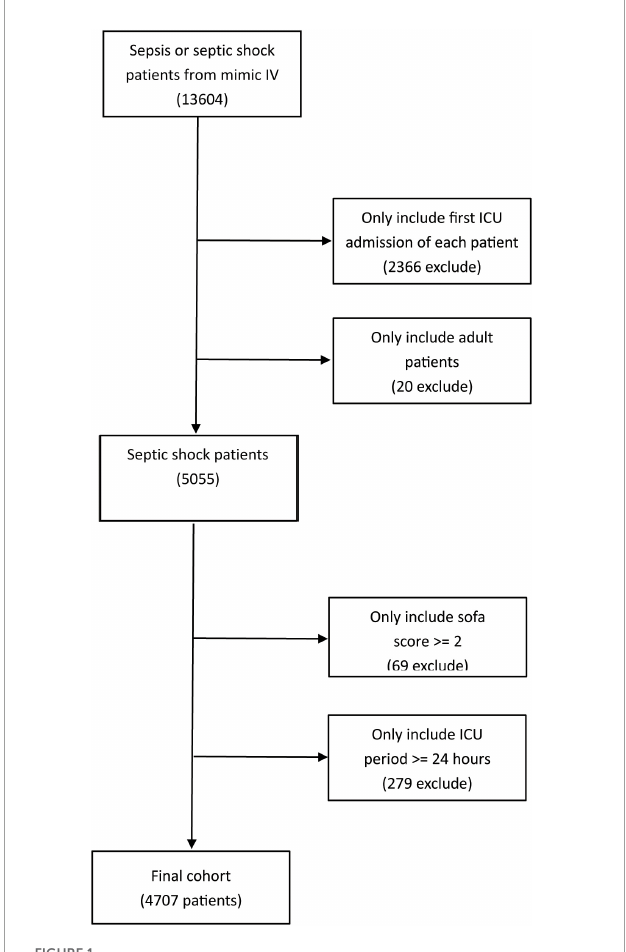
FIGURE1 Flowchart of the cohort selection in the present